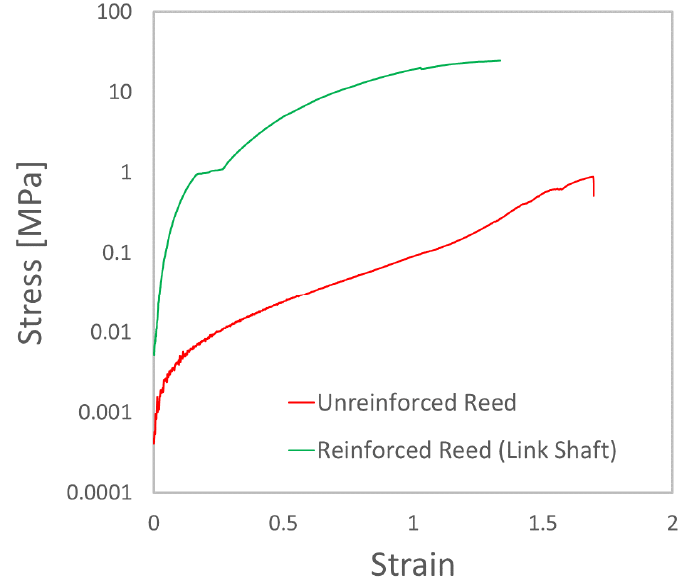
Figure 5. Representative stress–strain curves of radially tested reeds for both unreinforced, and giraffe tendon reinforced cases.